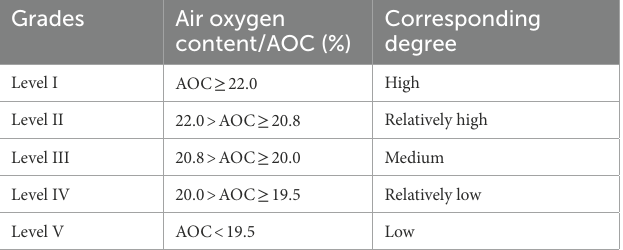
TABLE 2 Evaluation criteria for air oxygen